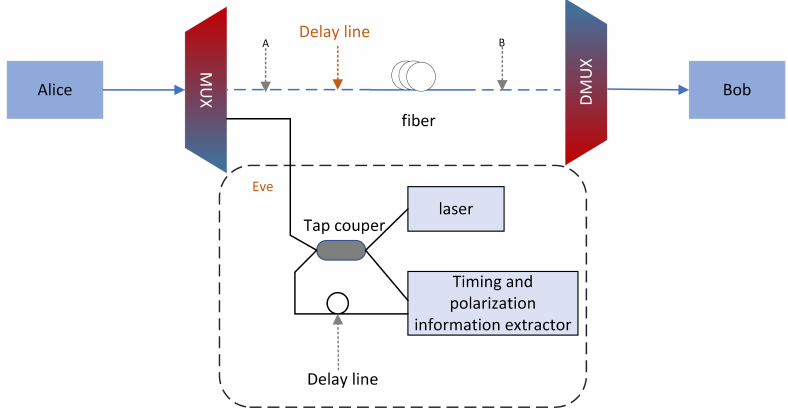
Figure 4. Scheme of a Trojan horse attacks with different wavelengths from original pulse.